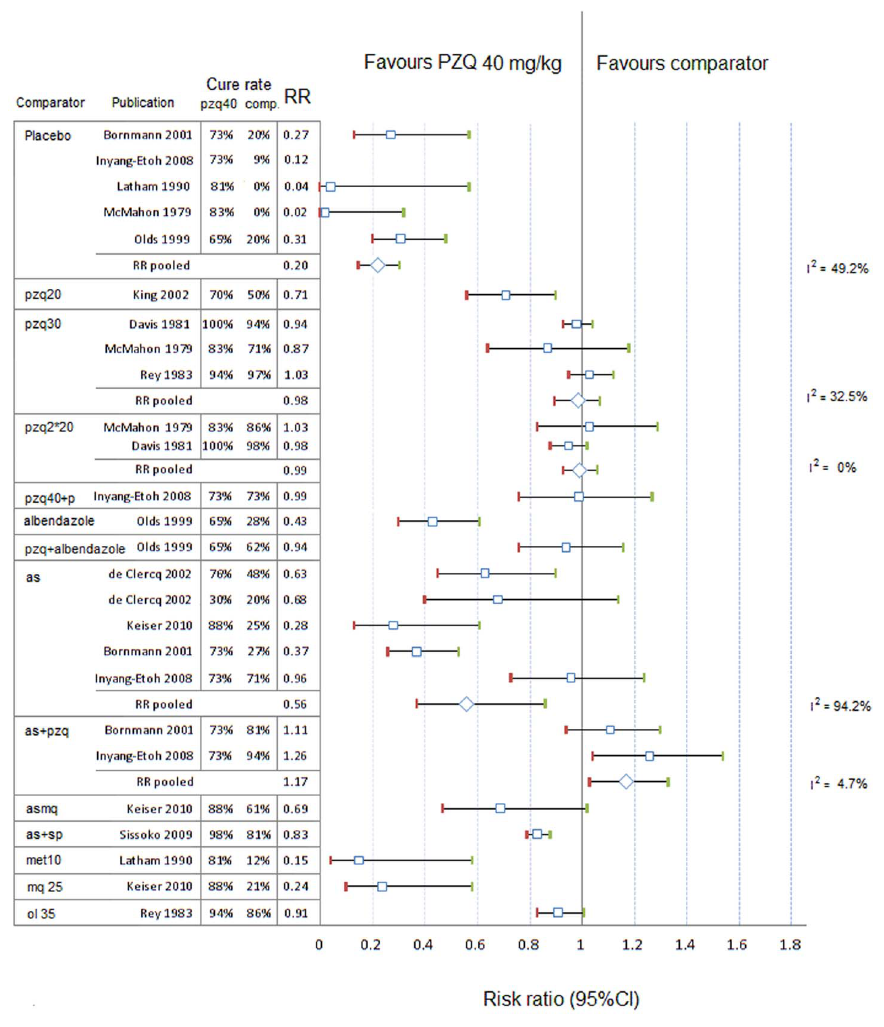
Figure 3. Forest plot of relative risks of cure rates with 95%CIs, S.haematobium , PZQ 40 mg/kg vs. comparators. as, artesunate; ol, oltipraz; pzq, praziquantel; sp, sulfadoxine-pyrimethamine; met, metrifonate, mq, mefloquine; p, placebo; comp, comparator; unit next to the drug: dose in mg/kg; RR, risk ratio; I 2 (Higgins’ I squared) is calculated for pooled subgroups as = 100%*( Q - df)/ Q , where Q is Cochran’s heterogeneity statistic and df the degrees of freedom. from non-comparative and comparative trials are presented in Figure 6. The mean ERR was over 90% in subjects of any age treated with PZQ doses greater than 10 mg/kg for S. haematobium and 87% or more for S. mansoni and 89% or more for S. mansoni/ haematobium mixed infections (40 mg/kg); for S. japonicum , the ERR was , 95% (40 and 60 mg/kg). There was no significant relationship (Spearman test) between the ERRs in subjects treated with any PZQ dose and species: S.